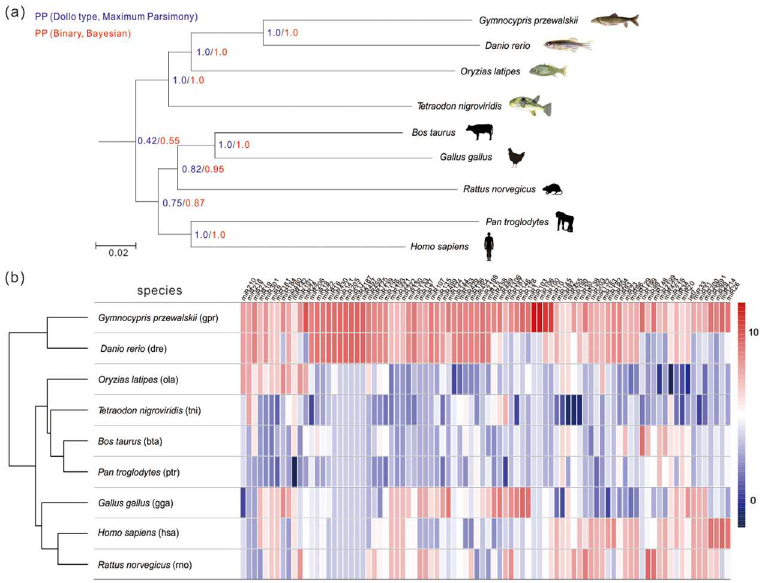
Fig 4. Phylogenetic position of G . przewalskii and clustering analysis result based on miRNA-wide scale datasets. (a) The miRNA data suggest that G . przewalskii is closely related to D . rerio , and in the branchof teleost fishes. Posterior probabilities(PP) of Maximum Parsimony (blue) and Bayesian(red) in each node are marked, respectfully. (b) Comparison of conservedmiRNA families in G . przewalskii and other 8 animalspecies shown in heatmapplot. The miRNA family data of other vertebrates were downloaded from miRBase 21.0. Rows represent each species with abbreviated miRBase three-letter names parenthesized. Columnsindicate the each miRNA families. Color coding was used to indicate the number of miRNA members, with dark red corresponding to the highestnumber (10) and dark blue the lowest (0).